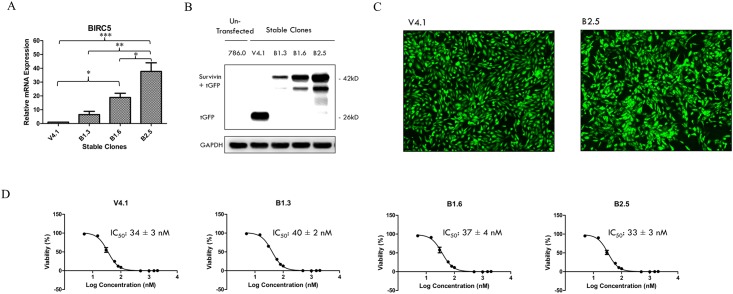
Survivin over-expressed stable clones.(A) B1.3, B1.6 and B2.5 constitutively over-expressed BIRC5 mRNA when compared to the control clone V4.1 which contains the expression vector without the BIRC5 gene insert. Among these clones, B2.5 increased amplification of the BIRC5 mRNA to the greatest extent (~38 fold). * p <0.05, ** p < 0.01 and *** p < 0.001 from corresponding control. (B) B1.3, B1.6 and B2.5 constitutively over-expressed survivin protein when compared to the control clone V4.1. The control clone V4.1 which contains the expression vector without the BIRC5 gene insert only expressed tGFP (26kD). Among the clones, B2.5 increased protein expression of survivin tagged with tGFP (42kD) to the greatest extent. (C) Visualisation of the C-terminal tGFP tag under a fluorescence microscope (100X) enables positive selection of transfected cells for stable cell line production. (D) The growth inhibitory IC50s of YM155 on these clones were similar.